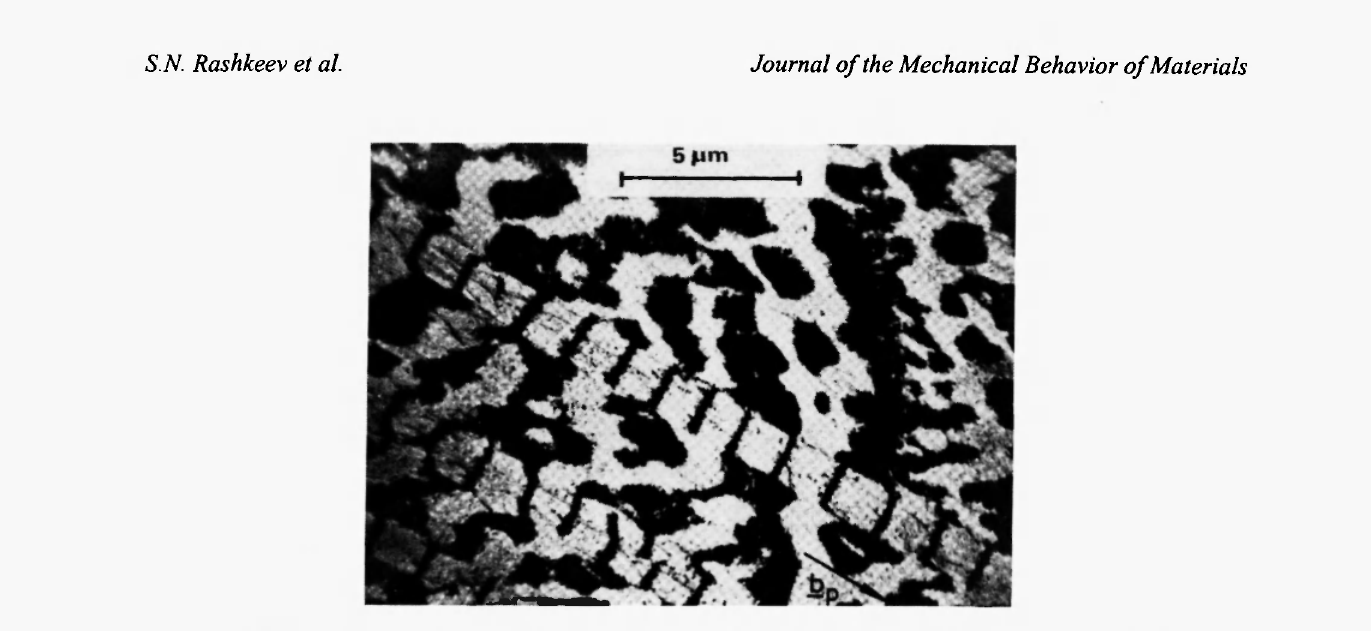
Fig. 1: The ladder structure of PSBs in a copper single crystal cycled at a strain amplitude in the plateau (the [121]-slice is shown, the crystal is pinned in the loaded state by neutron irradiation, after Laird et al.